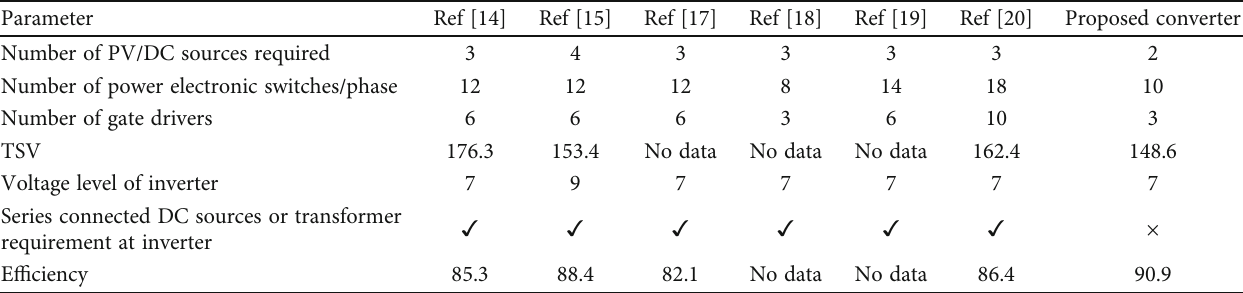
Table 2: Qualitative study of proposed work with other popular methods in literature.